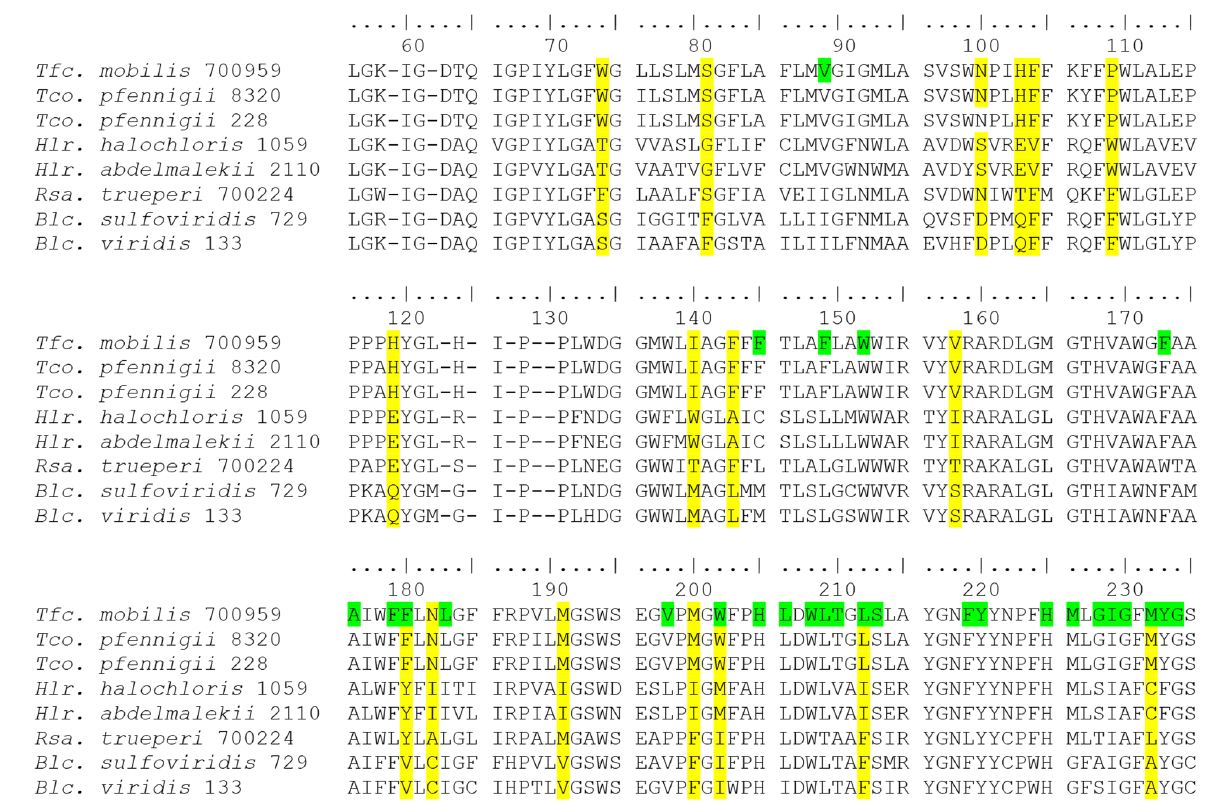
Frontiers in Microbiology |